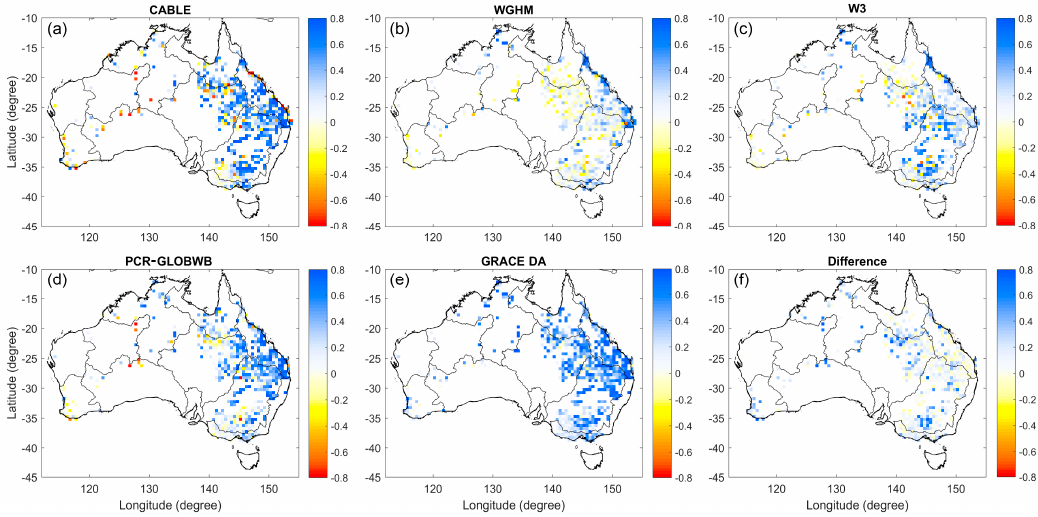
Figure 9. The correlation coefficient between the in situ Δ GL data and the Δ GWS estimate from four models (CABLE ( a ), WGHM ( b ), W3 ( c ), PCR-GLOBWB ( d )) and GRACE DA ( e ) in Australia. The difference between GRACE DA and PCR-GLOBWB (GRACE DA minus PCR-GLOBWB) is also shown ( f ).